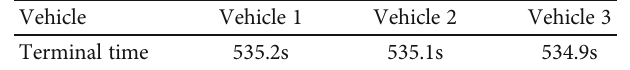
Table 4: Terminal times of lateral maneuver.